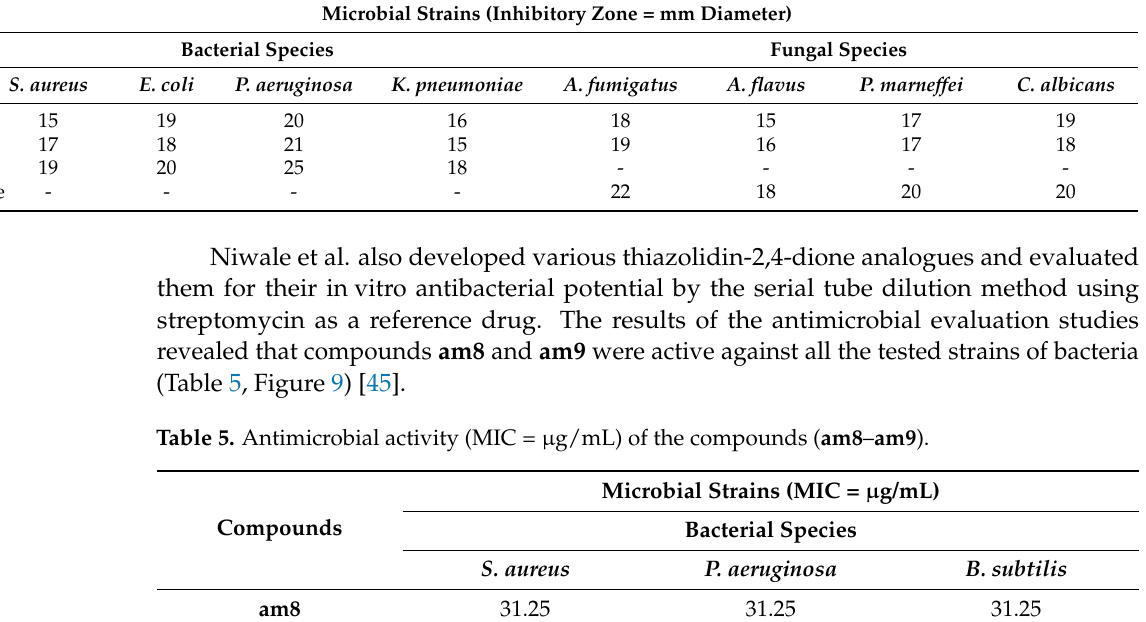
Table 4. Antimicrobial results (inhibitory zone = mm diameter) of the compounds ( am6 – am7 ). Microbial Strains (Inhibitory Zone = mm Diameter) Compounds Bacterial Species Fungal Species